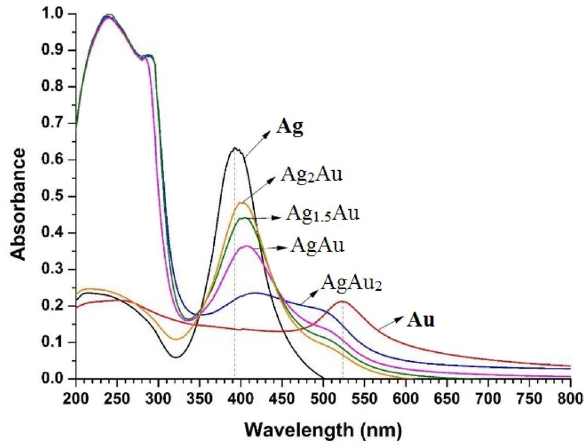
Fig. 4 UV–Vis-NIR absorbance spectrum of Au and AgNPs beside Au/Ag BNPs after green laser